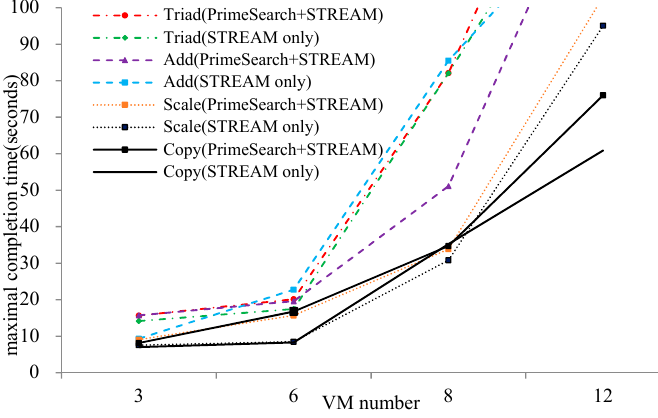
Figure 15. Maximum completion time of STREAM (server #3).